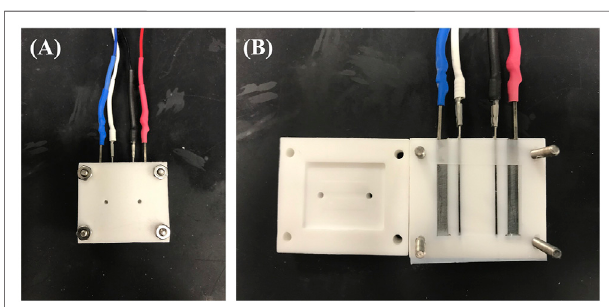
FIGURE 2 | Conductivity cell from (A) closed and (B) open viewpoint. Outer terminals (blue and red) are power leads and inner terminals (white and black) are sensing